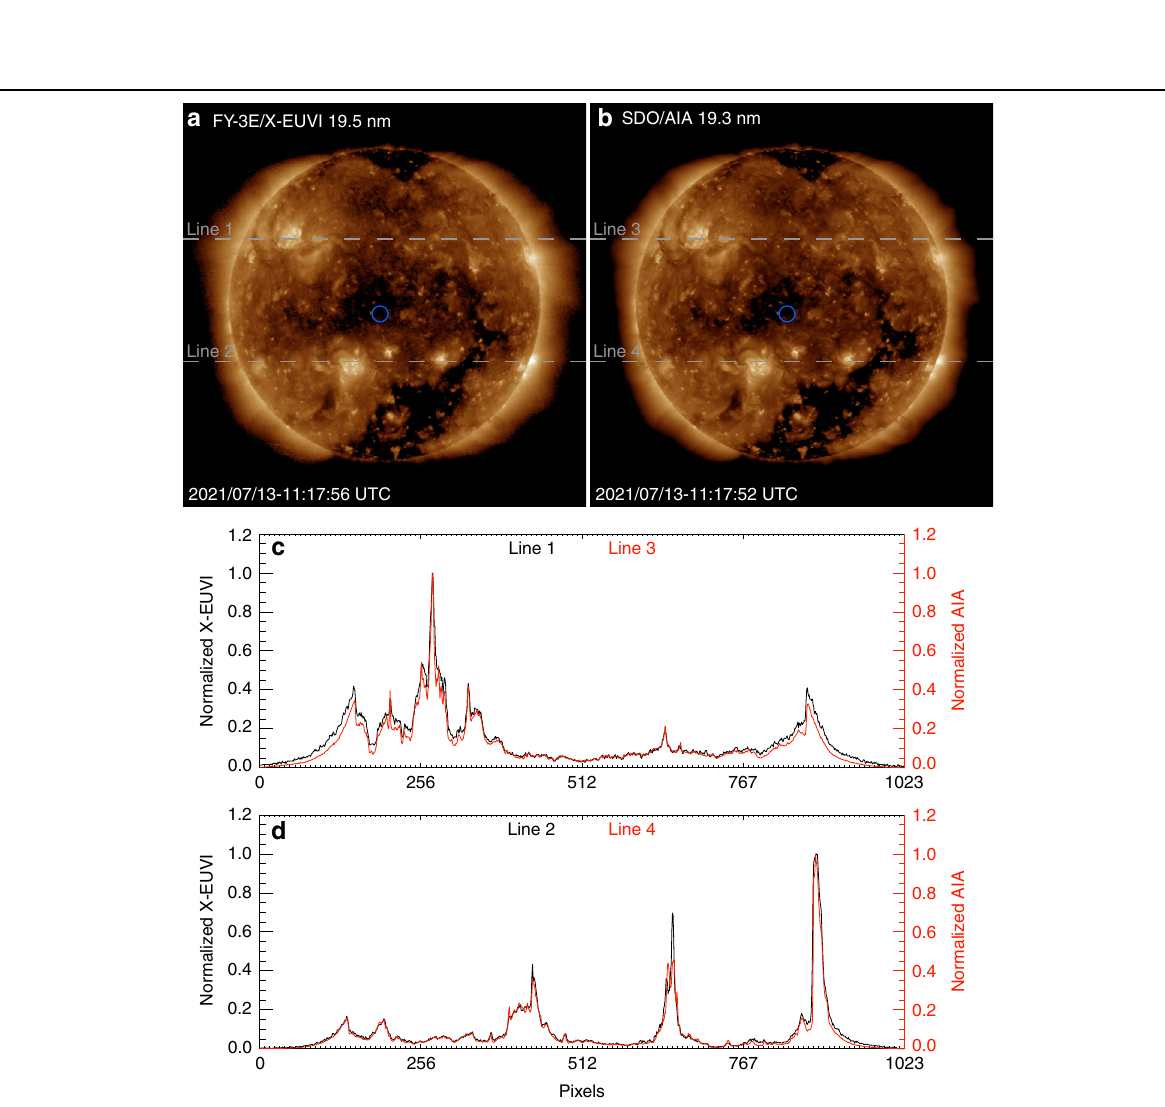
Fig. 5 Comparison of EUV images from X-EUVI and AIA. a The positions of line 1 and line 2 from X-EUVI. b The positions of line 3 and line 4 from AIA. c The normalized grey value distributions of line 1 and line 3. d The normalized grey value distributions of line 2 and line